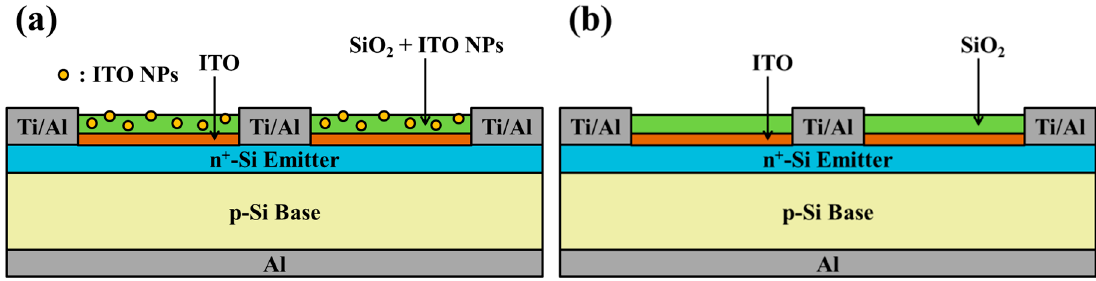
Figure 3. Schematic diagram of ( a ) a silicon solar cell coated with a compound ARC comprising an ITO layer (53 nm) and a layer of SiO 2 and dispersed ITO-NPs (250 nm); ( b ) a silicon solar cell coated with a compound ARC comprising an ITO layer (54 nm) and a SiO 2 layer that did not contain ITO-NPs (250 nm).